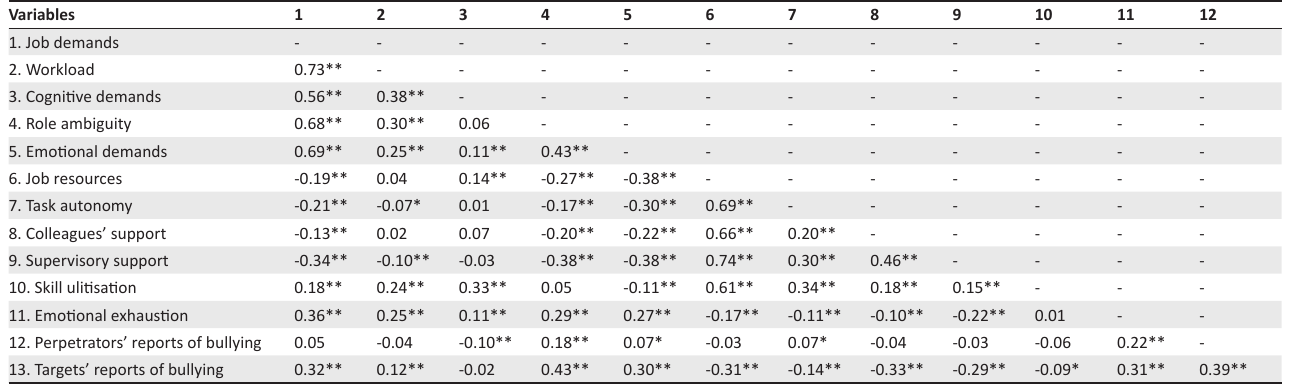
TABLE 1: Correlation amongst the study variables.